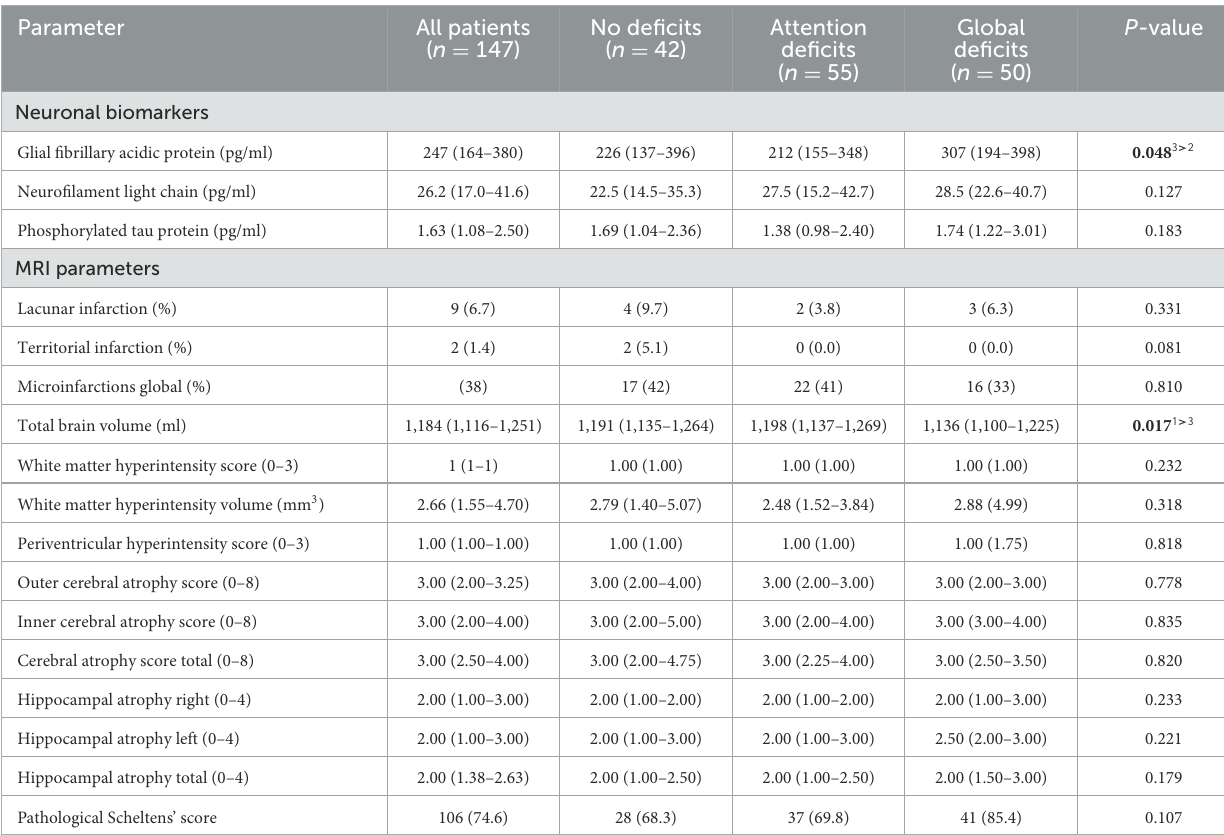
TABLE 3 Neurochemical and neuroradiological measures according to cognitive